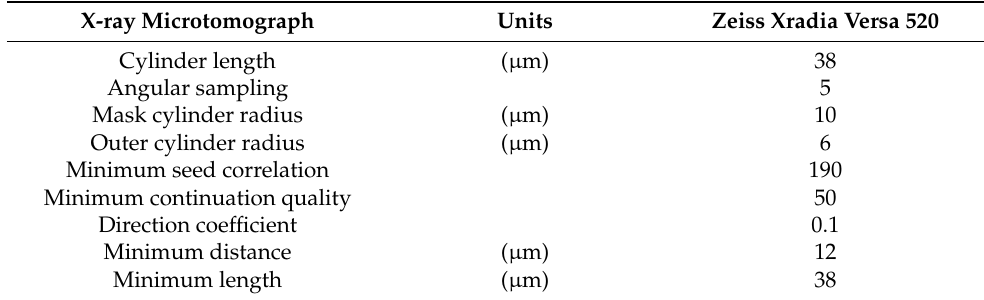
Table 3. Used settings for fiber tracing with the XFiber extension (Avizo 9.4) based on the µ CT data. X-ray Microtomograph